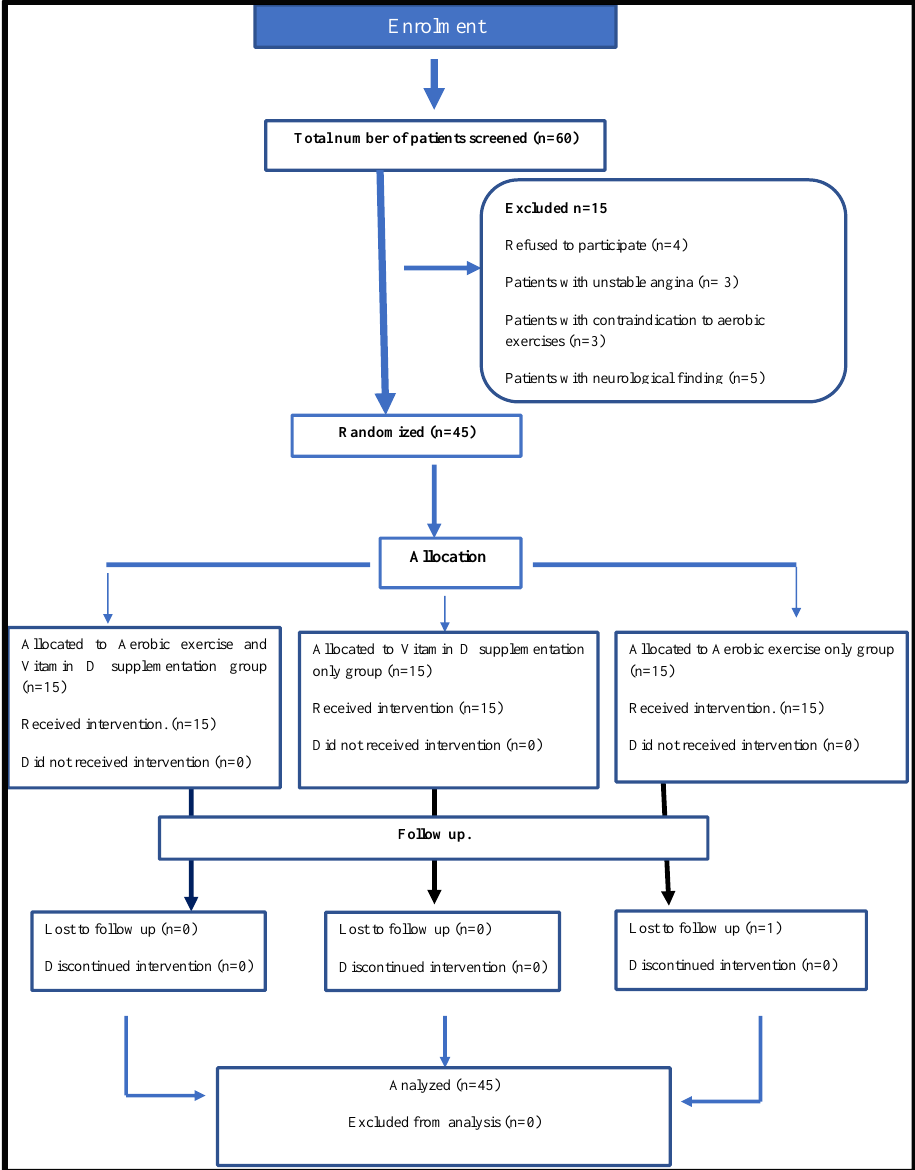
Figure 1. Flow chart in accordance with the CONSORT statement .